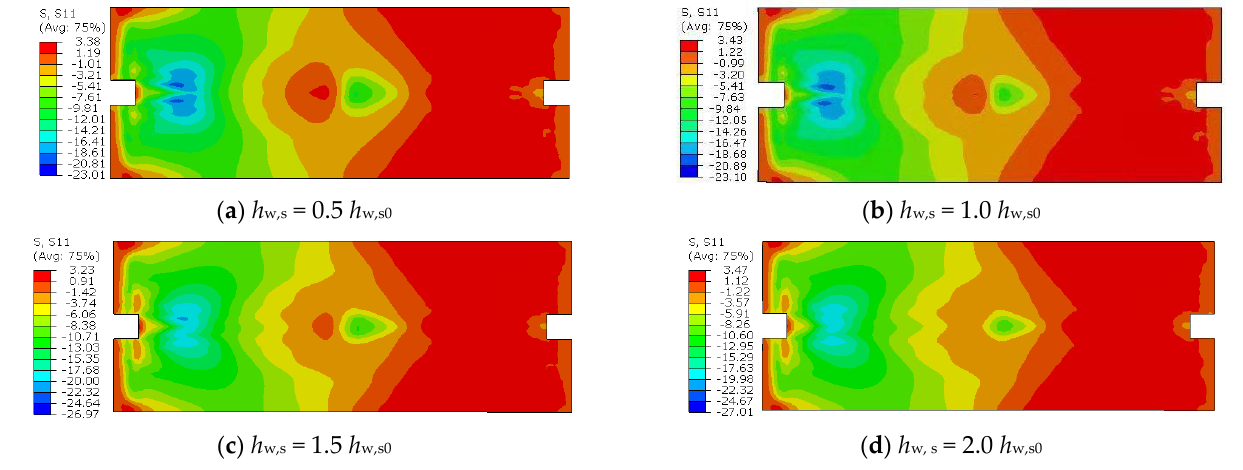
Figure 20. Stress nephograms of a concrete slab for different h w,s values.